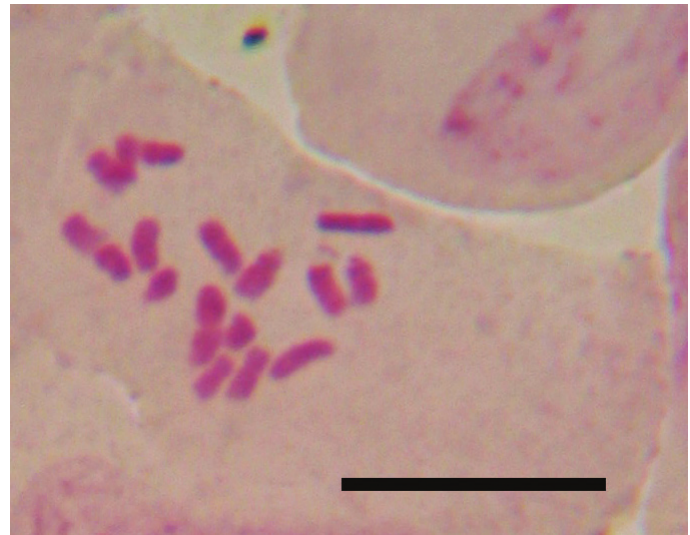
Figure 7. Centaurea deusta Ten., 2 n = 18. Scale bar: 10 μm. first from Calabria, and it agrees with previous counts obtained from Italy (Damboltd et al. 1973, Brullo et al. 1992, Tessitore et al. 1994). All the extra-Italian counts also gave 2 n = 18 chromosomes (Rice et al. 2014 onwards). Mathas (1976) found one B- chromosome on plants from Puglia and